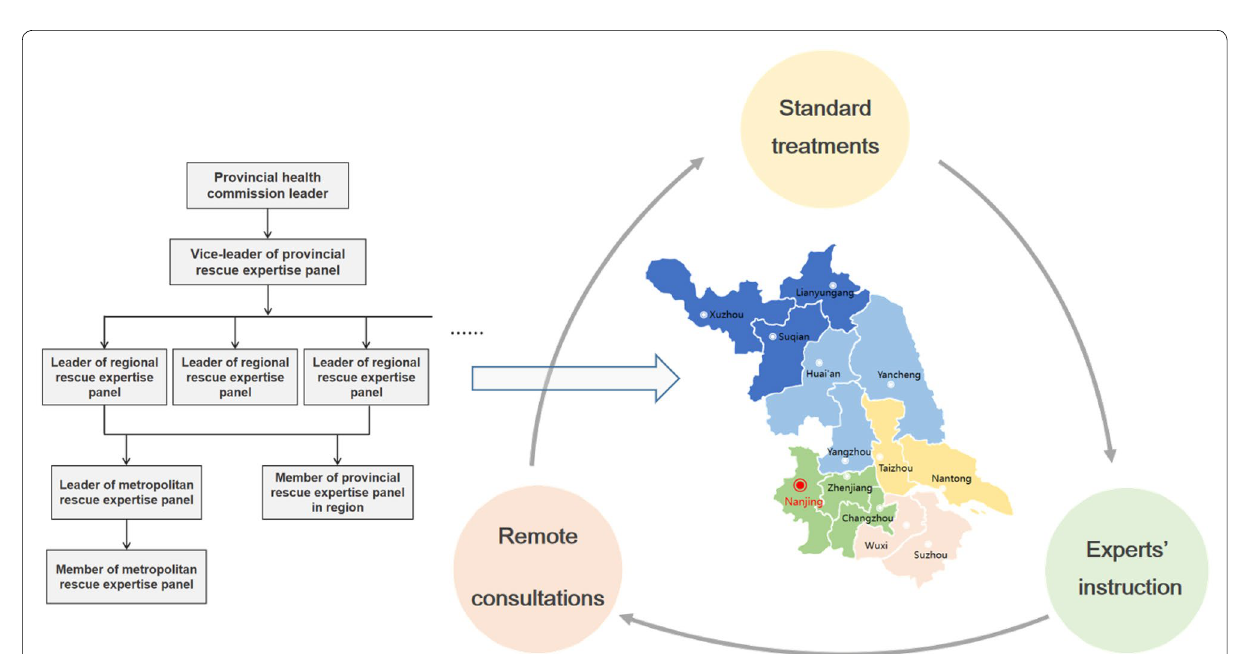
Fig. 3 Organization chart of hierarchical management